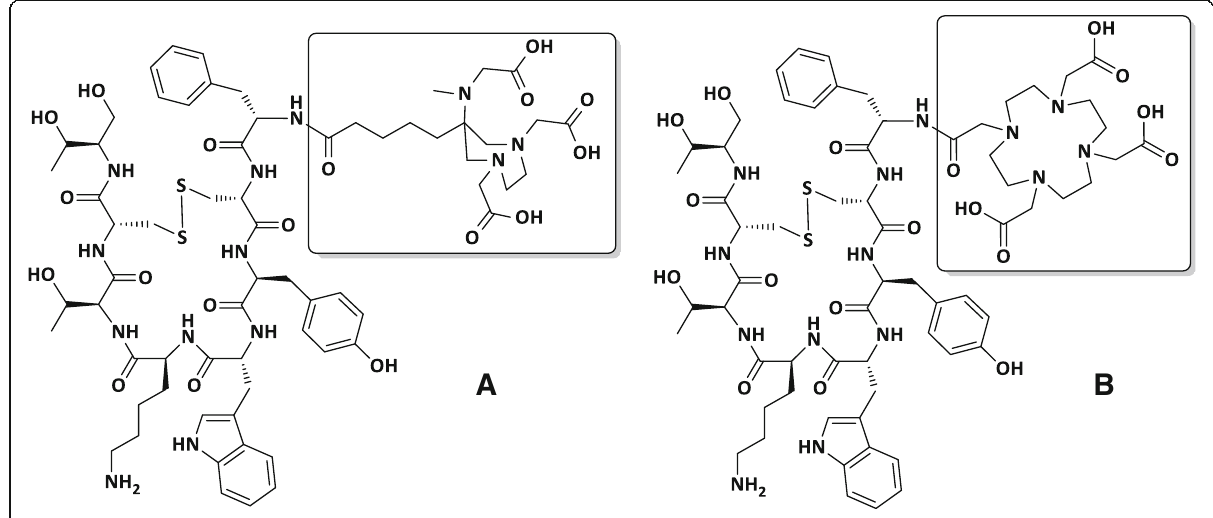
Fig. 1 Structures of TOC coupled with a DATA and b DOTA. Chelator structures are